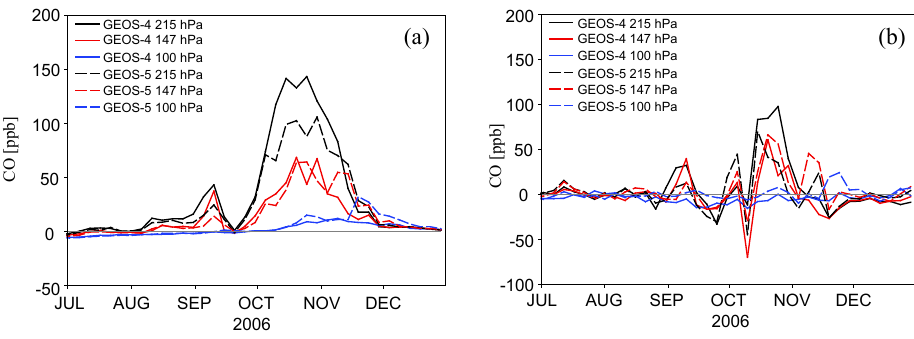
Fig. 11. Simulated upper tropospheric CO concentrations at 100, 147 and 215hPa determined as the differences between two GEOS-Chem simulations: (a) both for 2006, but one with GFED v2 biomass burning emissions for 2006 and the other with climatological biomass burning emissions and (b) one for 2006 and the other for 2005 and both with GFED v2 8-day biomass burning emissions for 2006. Results from GEOS-Chem simulations driven by GEOS-4 and GEOS-5 meteorological data are both shown. Values are averages over the Indonesia domain (see Fig. 1).